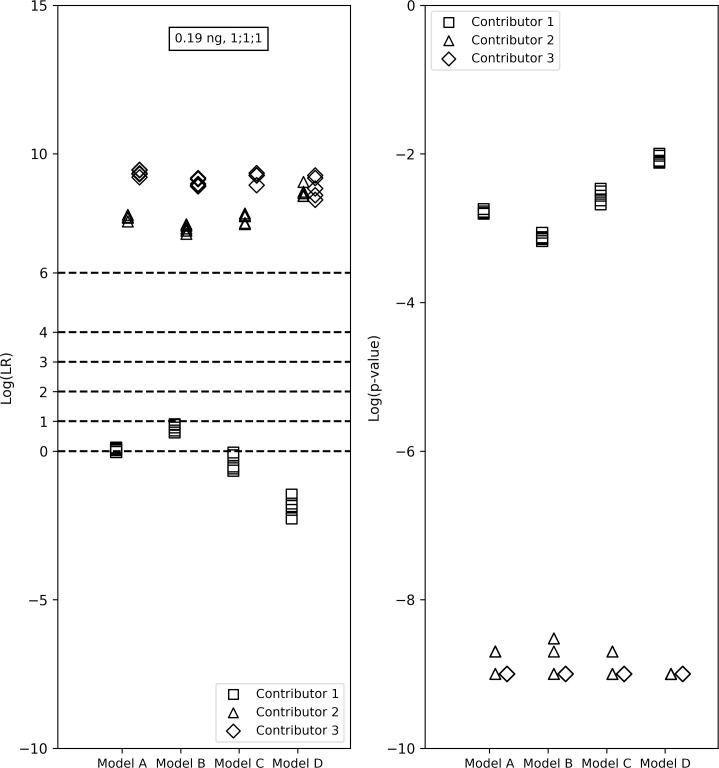
LR verbal expression levels and the LRs and p-values from the four models for the true contributors in a 1:1:1, 0.047ng 3-person sample.Models C and D (constant mixture ratio assumption) had LRs < 1. Model B (varying mixture ratio assumption) suggested ‘Weak’ interpretation. In Model A, the LRs fell both above and below 1 (log10(LR)s ranging from -0.03 to 0.11).